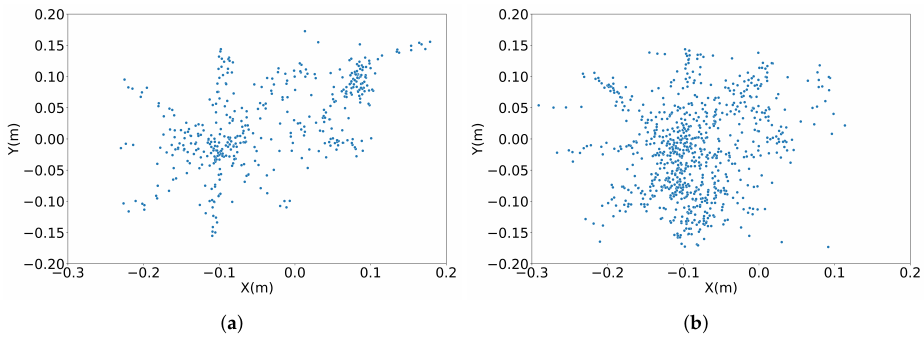
Figure 6. Distribution of fixation points. ( a ) Attention-guide mode, ( b ) automated mode.